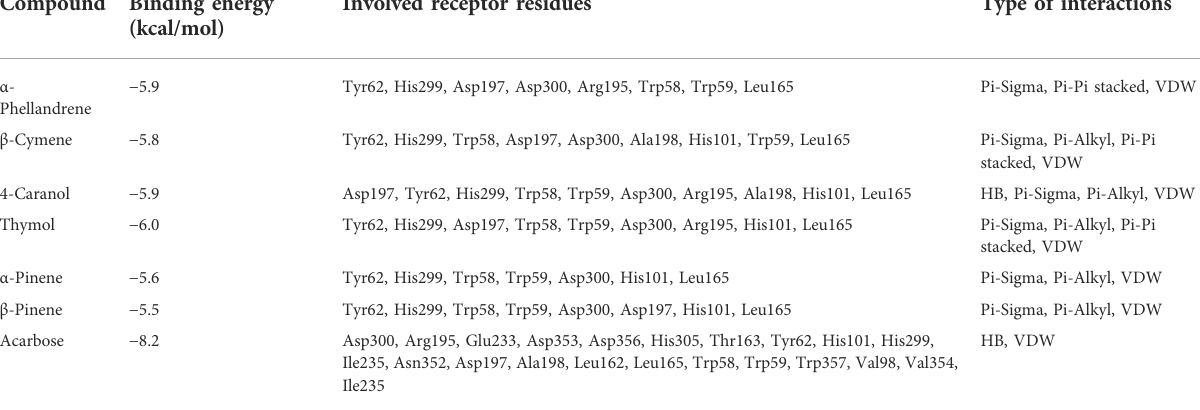
TABLE 3 Docking outcomes of major compounds in the NS essential oil against the human pancreatic α -amylase protein. Compound Binding energy Involved receptor (kcal/mol)